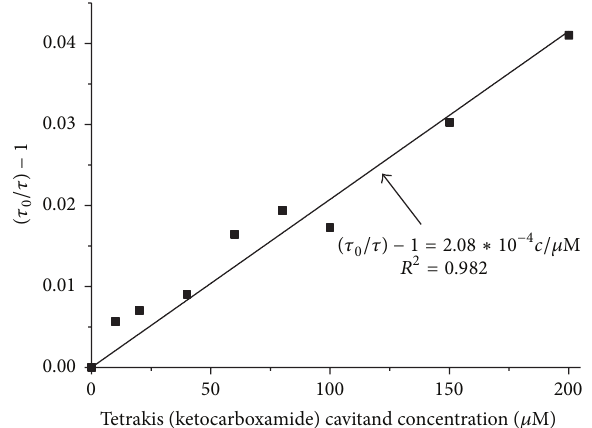
Figure 4: Stern-Volmer plot for the fluorescence lifetime of anthracene.